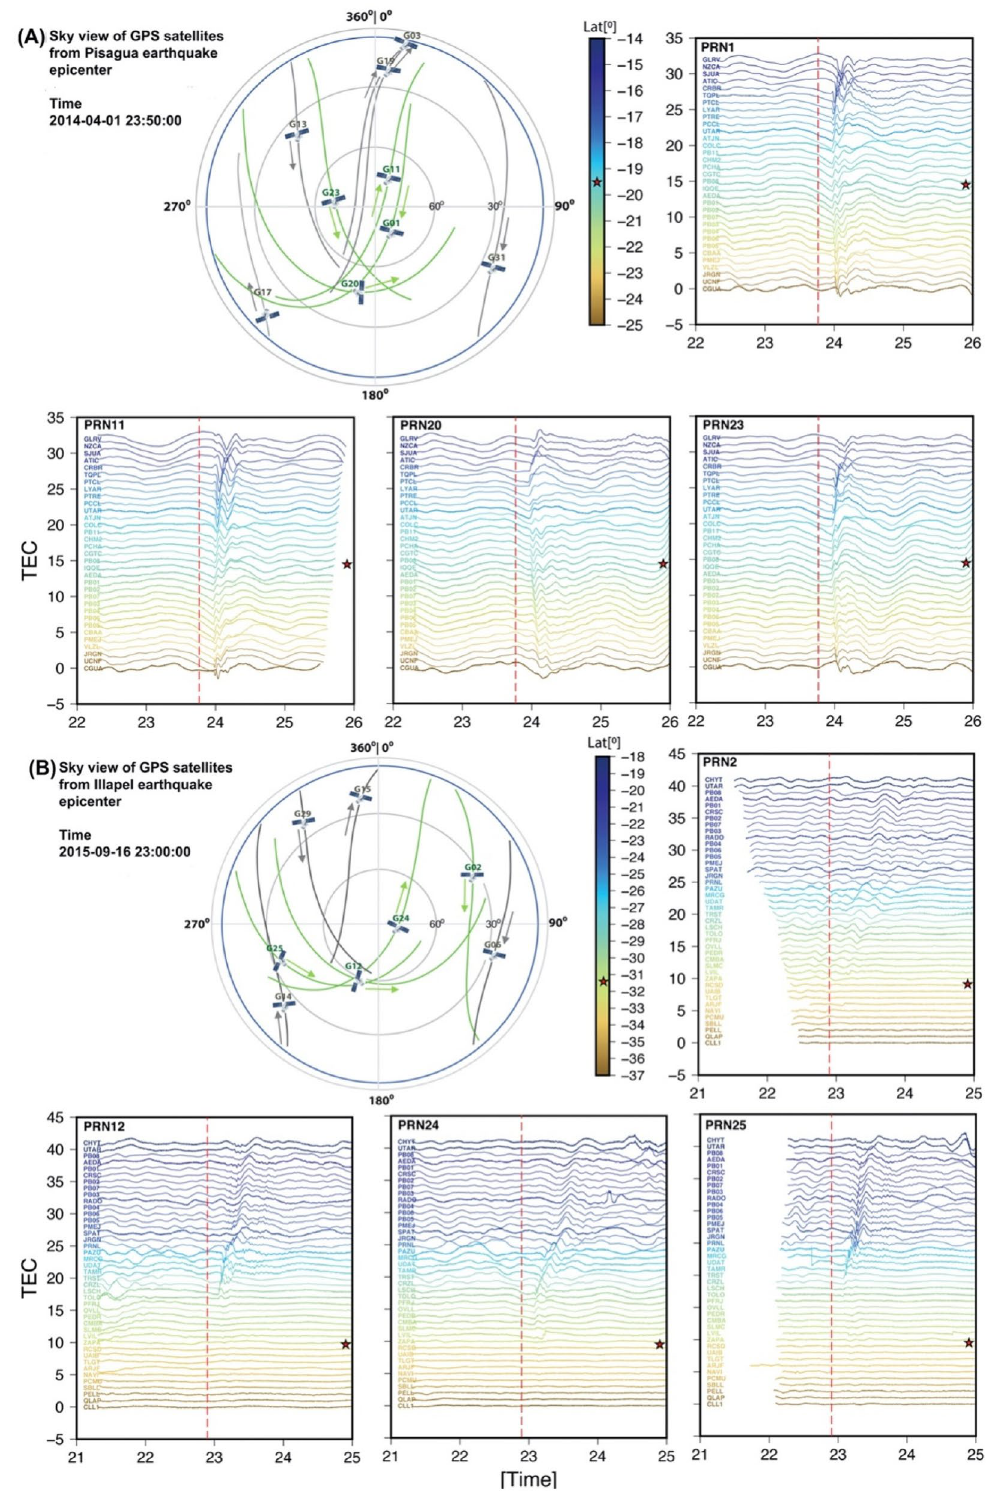
Figure 3. Imaginary sky view of the GPS satellites from the 2014 Pisagua earthquake (A) and Pisagua earthquake (B) epicenters. The blue circle represents the 20° elevation, which was used as criteria for the utilization of the GPS satellite data. The residual VTEC is presented for PRNs 01, 11, 20, and 23 during the 2014 Pisagua earthquake ( A ) and for PRNs 2, 12, 24, and 25 during the 2015 Illapel earthquake ( B ). The dotted lines mark the time of the earthquakes. The colored lines represent the residual VTEC regarding the locations of GPS latitudinally from north to south. The red stars indicate the latitude of the earthquake